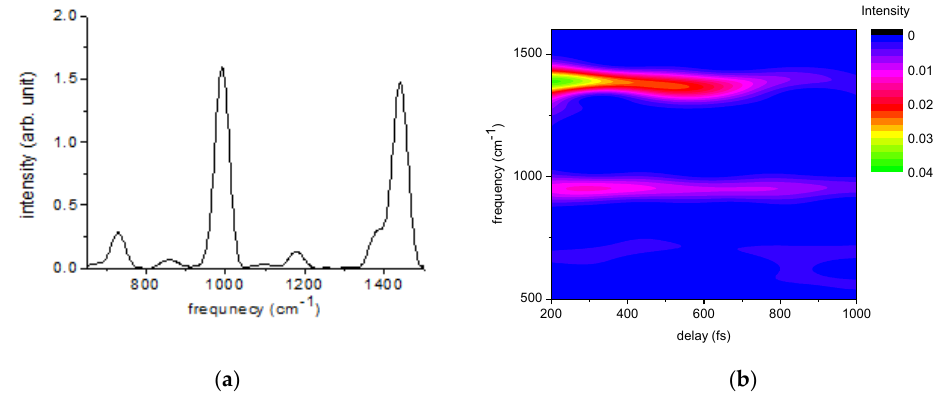
Figure 5. ( a ) Fourier power spectrum; and ( b ) spectrogram calculated from the time-resolved absorption change trace shown in Figure 4b. The spectrogram was calculated using a Blackman window with a full width half maximum of 280 fs. Table 1. Molecular vibration dynamics estimated by the linear prediction singular value decomposition (LP-SVD) method.